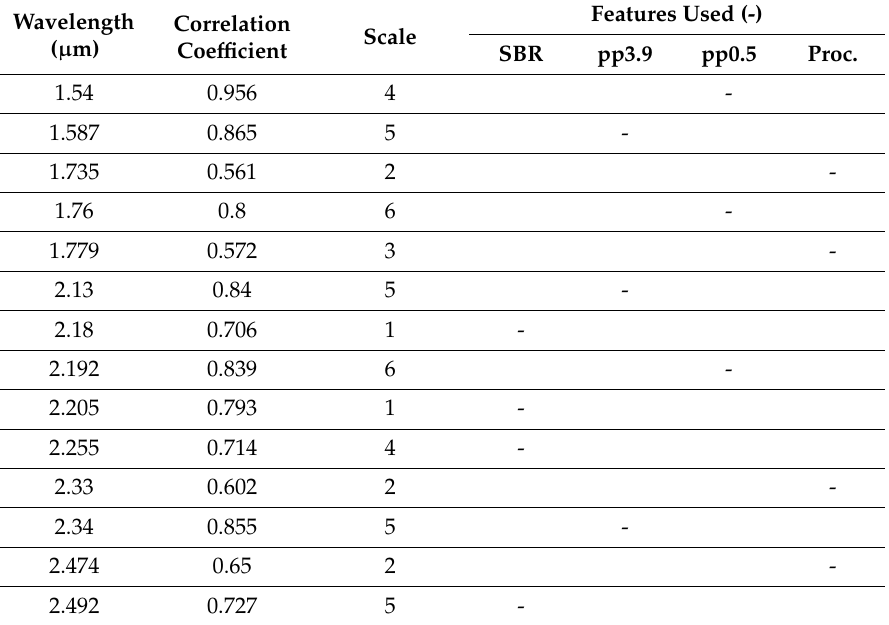
Table 4. List of wavelet spectral features best correlated to froth properties and ore processability. Wavelength